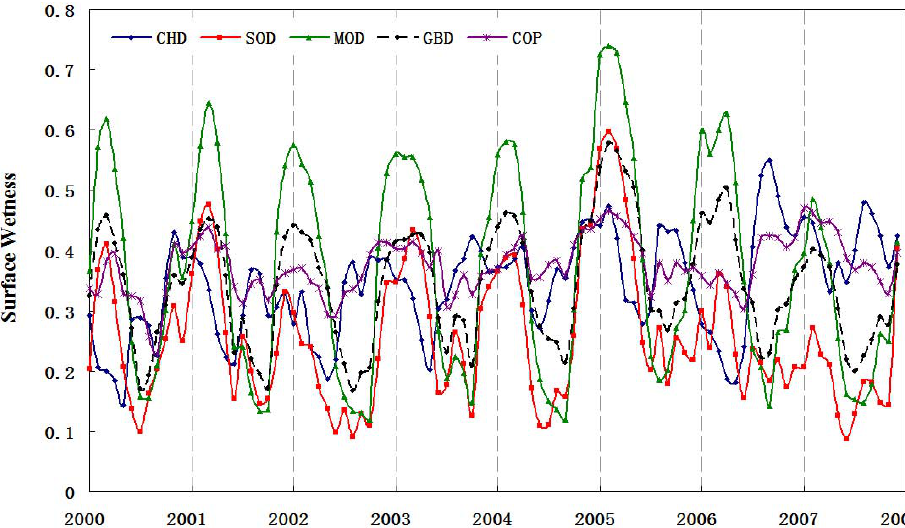
Fig. 8. Monthly variations of surface wetness over five dust source regions during the study period. The surface wetness is derived from the NASA Modern Era Retrospective-analysis for Research and Application (MERRA) dataset. Five dust regions include the Chihuahuan Desert (CHD), the Sonoran Desert (SOD), the Mojave Desert (MOD), the Great Basin Desert (GBD) and the Colorado Plateau